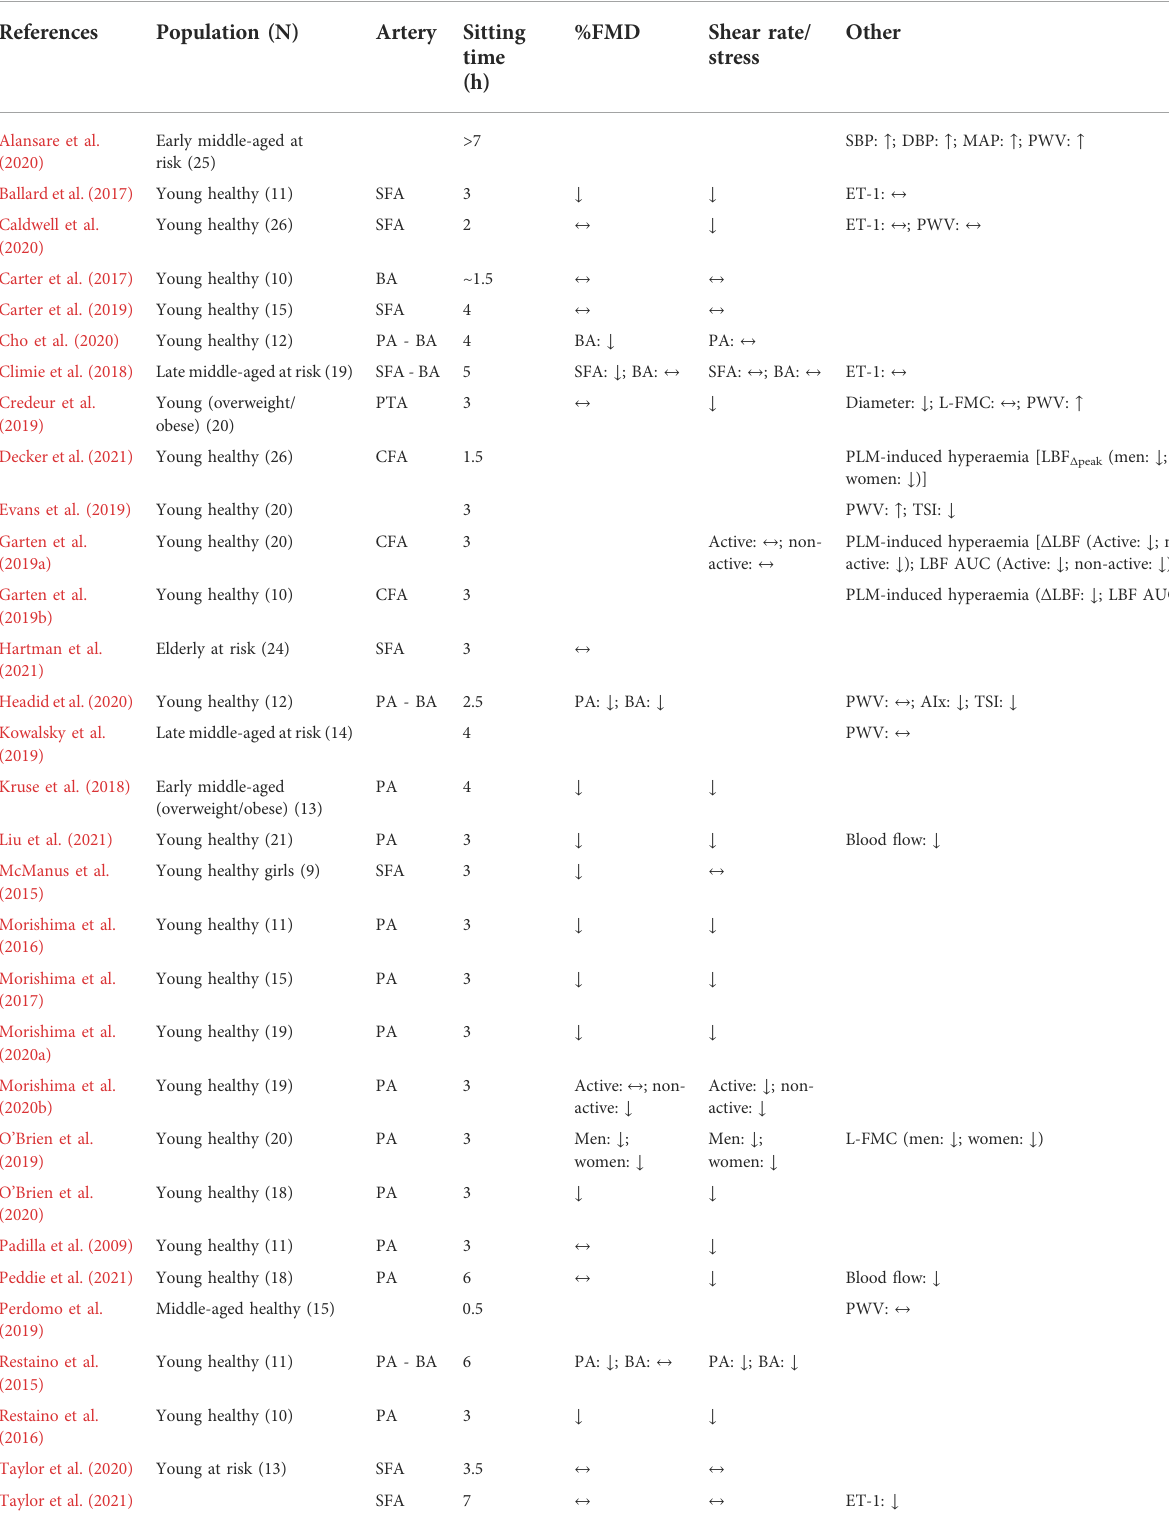
TABLE 1 The acute effects of prolonged sitting on vascular health